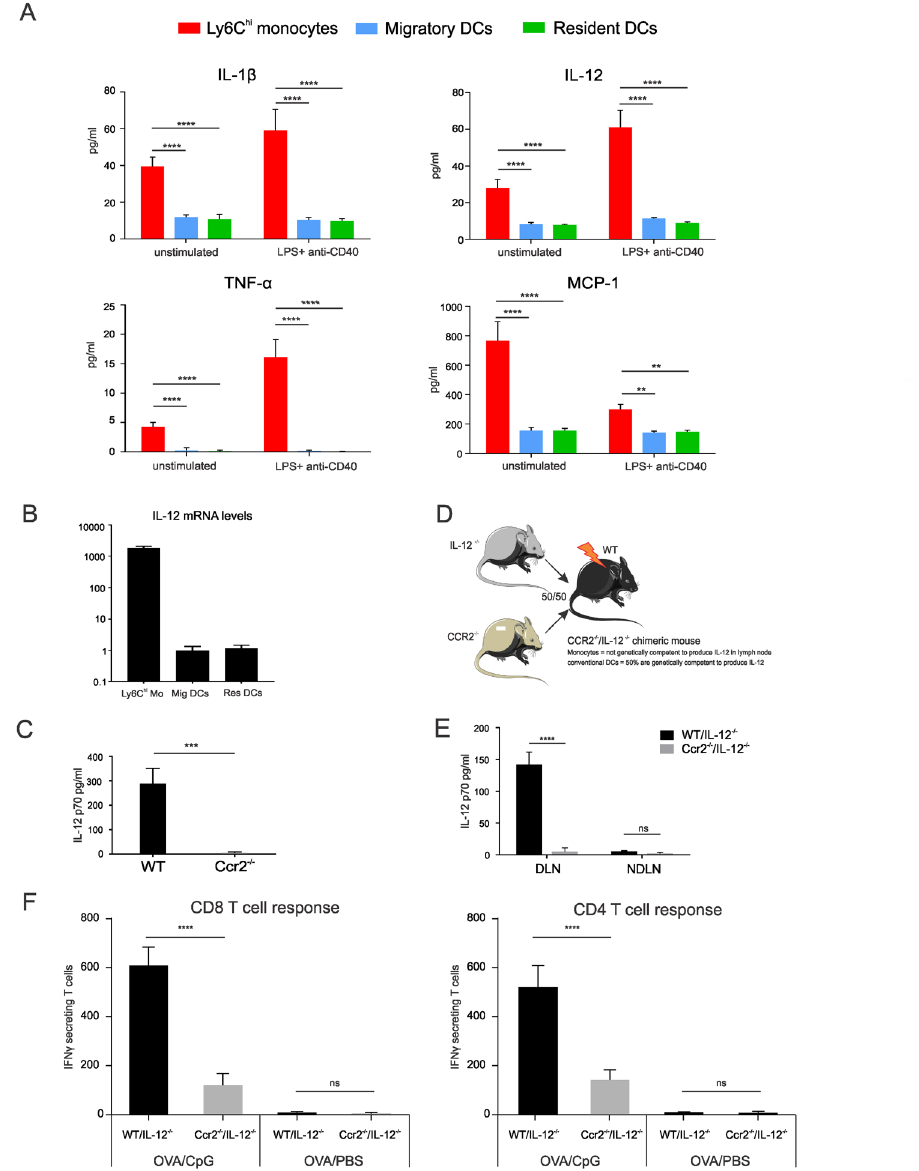
Figure 7. Ly6C hi monocytes constitute the major source of IL-12 that drives IFN- γ T cell responses. ( A ) Graphs showing cytokine production by Ly6C hi monocytes, migratory DCs and resident DCs sorted from the pooled popliteal lymph nodes of mice (n = 40) injected with CpG 24 h earlier. 2 × 10 5 sorted cells were cultured for 48 h either without further stimulation or stimulated with a low dosis of LPS (100 ng/ml) and anti-CD40 (1 µ g/ml). All data points indicate means + / − SD for five replicates. ( B ) Relative IL-12 mRNA transcript levels in Ly6C hi monocytes, migratory DCs and resident DCs sorted from the pooled popliteal lymph nodes of mice (n = 20) injected with CpG 24 h earlier. ( C ) IL-12p70 titers determined in the supernatans of the draining lymph nodes isolated from CpG injected WT and Ccr2 − / − mice. Lymph nodes were isolated 24 h post CpG injection and cultured for an additional 48 h ex vivo (n = 5; mean + / − SD). ( D ) Schematic overview of the procedure applied to generate mixed IL-12 − / − /Ccr2 − / − chimeric mice. ( E ) IL-12 p70 titers in the supernatans of the draining and non-draining lymph nodes of CpG injected WT/IL-12 − / − and Ccr2 − / − /IL-12 − / − chimeric mice (n = 5; mean + / − SD). ( F ) ELISPOT quantification of the numbers of IFN- γ secreting T cells of WT/IL-12 − / − and Ccr2 − / − / IL-12 − / − chimeric mice immunized with OVA/CpG through a prime booster schedules (n = 5; mean + / − SD). Data shown are a representative of two independent